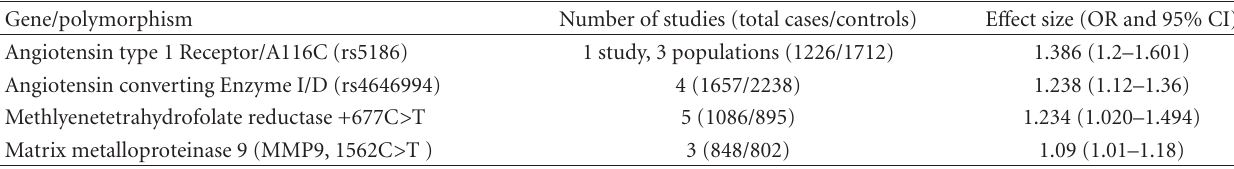
Table 2: SNPs associated with AAA after meta-analysis of candidate gene studies [25, 26].